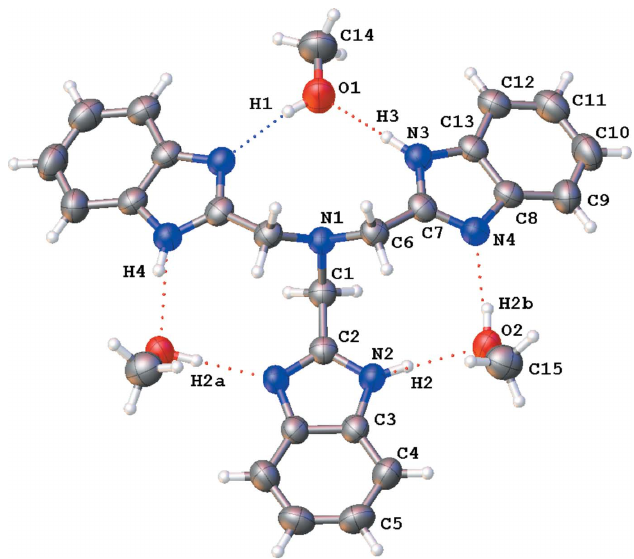
Figure 1 Molecular structure of the title compound, with displacement ellipsoids for non-H atoms at the 50% probability level. For all disordered H atoms, a single site was retained, in order to emphasize the O—H (cid:2)(cid:2)(cid:2) N and N— H (cid:2)(cid:2)(cid:2) O hydrogen bonds (dotted lines). Non-labelled atoms are generated by the symmetry operation 1 (cid:4) x , y , z